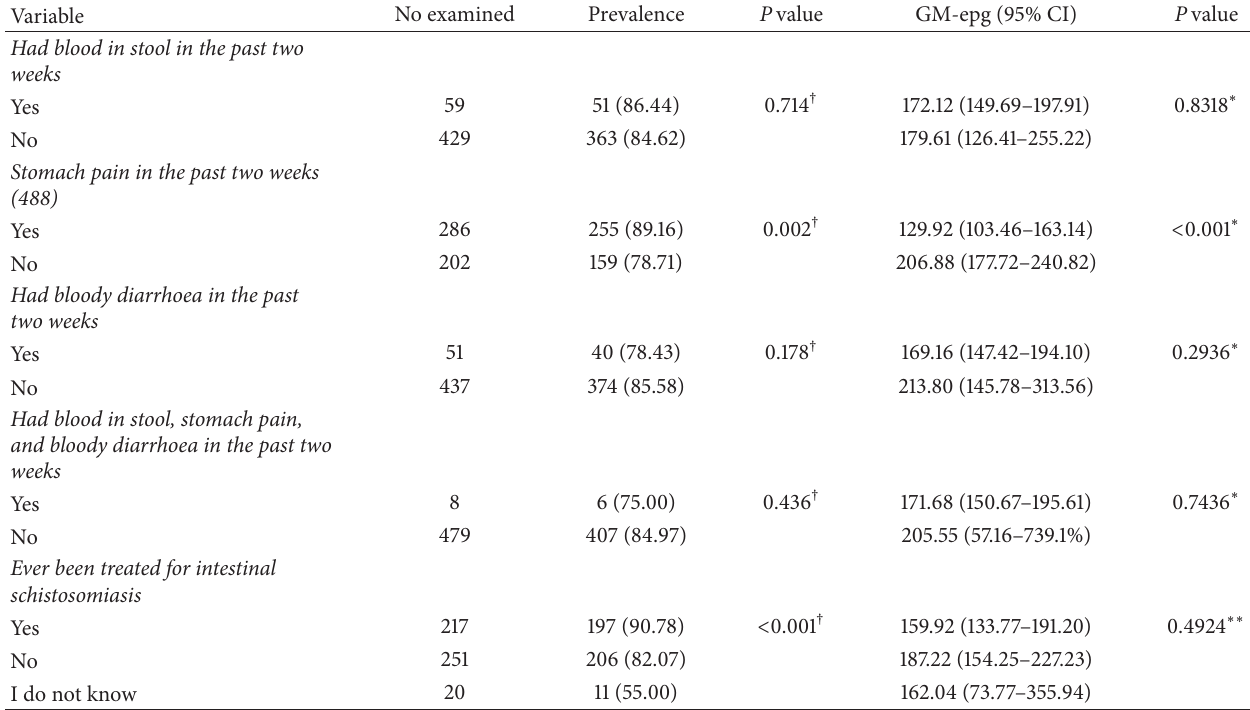
Table 3: Prevalence and intensity of S. mansoni by history of clinical morbidity and treatment history.